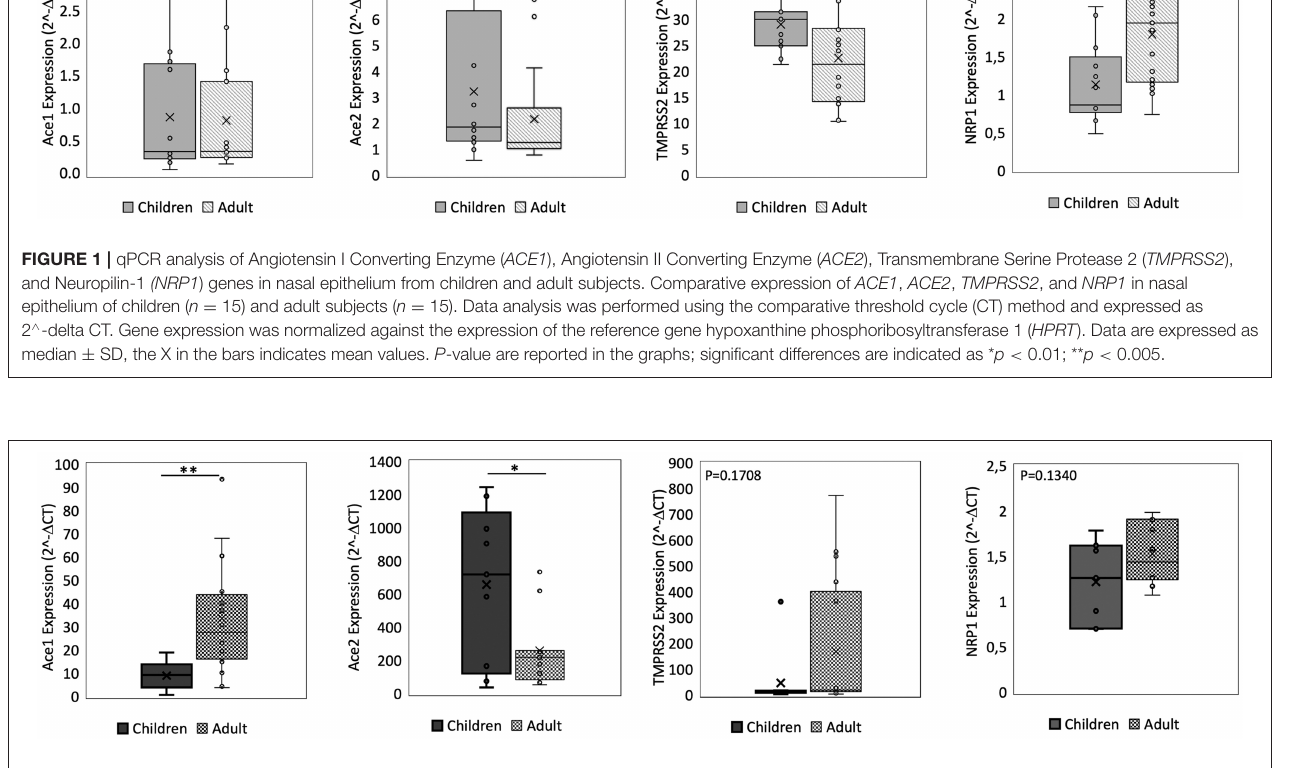
FIGURE 2 | qPCR analysis of Angiotensin I Converting Enzyme ( ACE1 ), Angiotensin II Converting Enzyme ( ACE2 ), Transmembrane Serine Protease 2 ( TMPRSS2 ), and Neuropilin-1 ( NRP1 ) genes in small intestine from children and adult subjects. Comparative expression of ACE1 , ACE2 , TMPRSS2 , and NRP1 in small intestine of children ( n = 15) and adult subjects ( n = 15). Data analysis was performed using the comparative threshold cycle (CT) method and expressed as 2 ∧ -delta CT. Gene expression was normalized against the expression of the reference gene hypoxanthine phosphoribosyltransferase 1 ( HPRT ). Data are expressed as median ± SD, the X in the bars indicates mean values. P -value are reported in the graphs; significant differences are indicated as * p < 0.01; ** p <